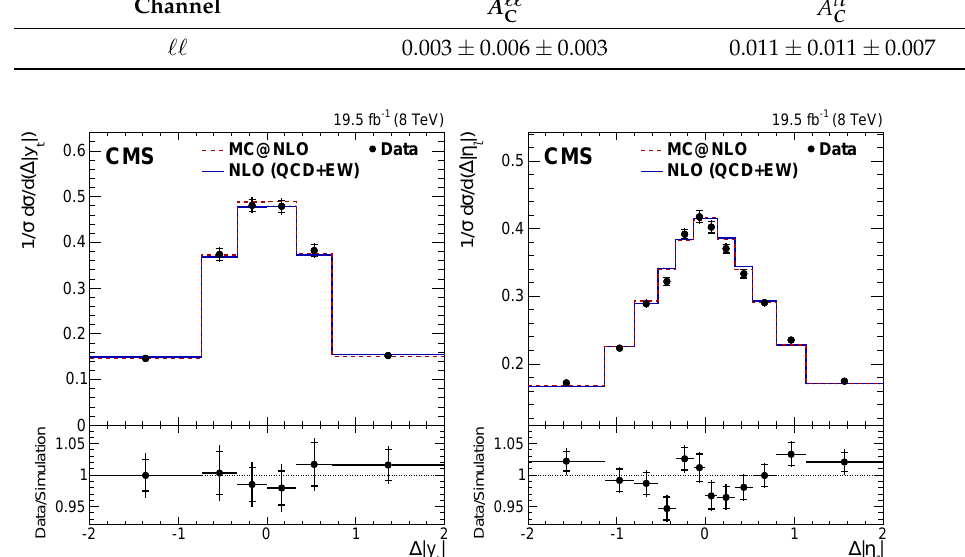
Figure 12. Unfolded data distribution for ∆ | y | ( left ) and ∆ | η | ( right ) [44] compared to the predictions from the MC@NLO at NLO [46] and the NLO+EW SM predictions